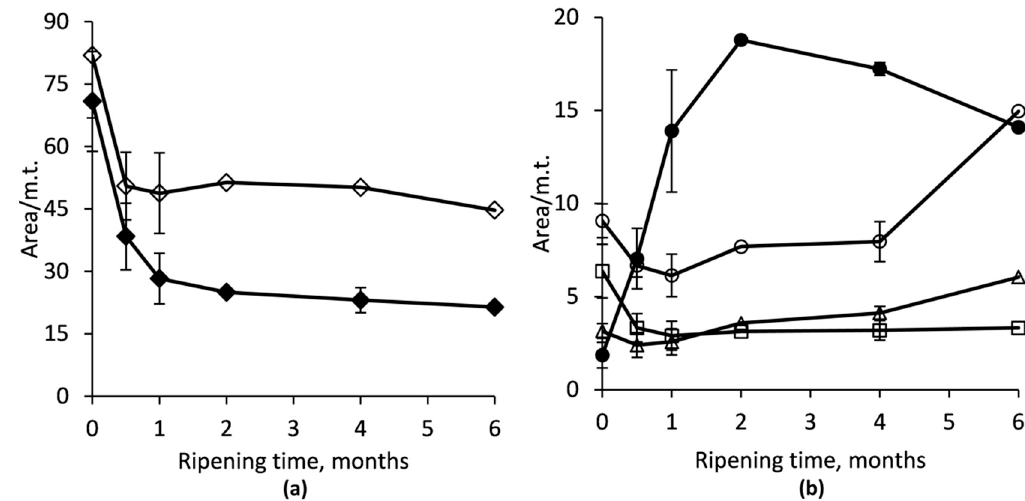
Figure 2. Change of the content (normalized peak area) of main intact CN (a) and their primary degradation products (b) during RO-cheese ripening. α s1 -CN ( ♦ ): sum of α s1 -CN-8P and α s1 -CN-9P; β -CN ( ◊ ): sum of β -CN(A 1 ), β -CN(A 2 ), and β -CN(B); α s1 -I-CN ( ● ): sum of α s1 -I-CN-8P and α s1 -I-CN-9P; γ 1 -CN ( ○ ): sum of γ 1 -CN(A 1 ) and γ 1 -CN(A 2 ); ( □ ): γ 2 -CN; ( ∆ ): γ 3 -CN; m.t., migration time.